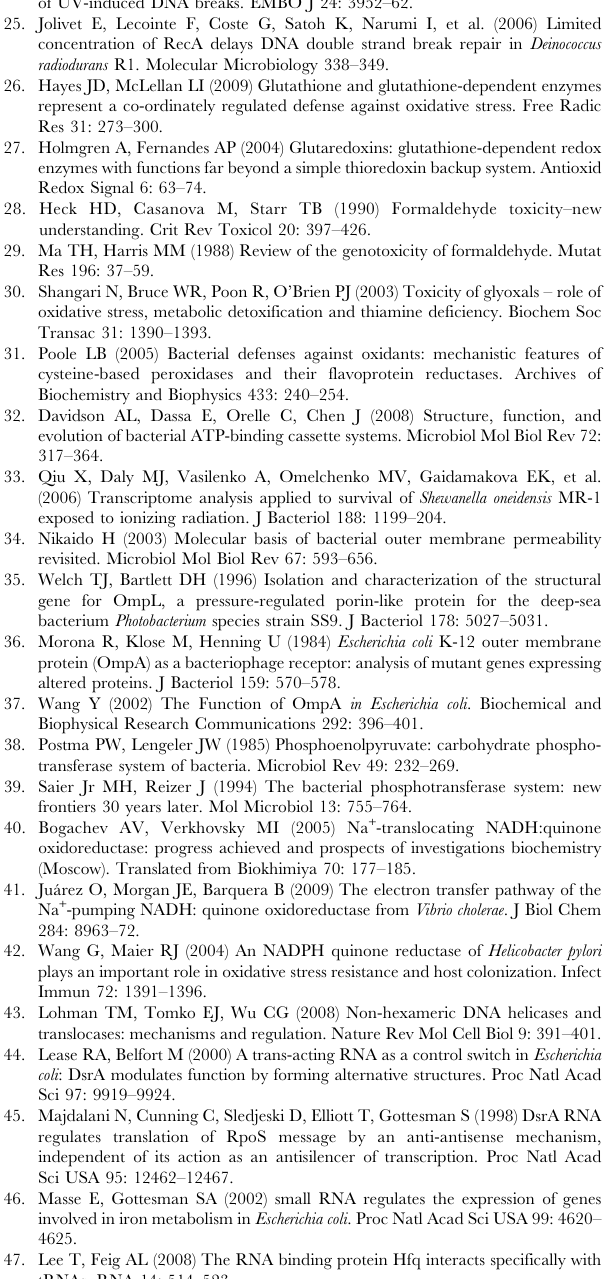
Figure S3 Alignment of the RecA protein sequence from P. angustum with its homolog from E. coli . Boxed residues indicates similar amino acids that are recognized by the primary antibody against RecA. Figure S4 2D-DIGE experimental workflow from seven repli- cates. The three landmarks used for gels matching are indicated in blue, for the seven standard gels.